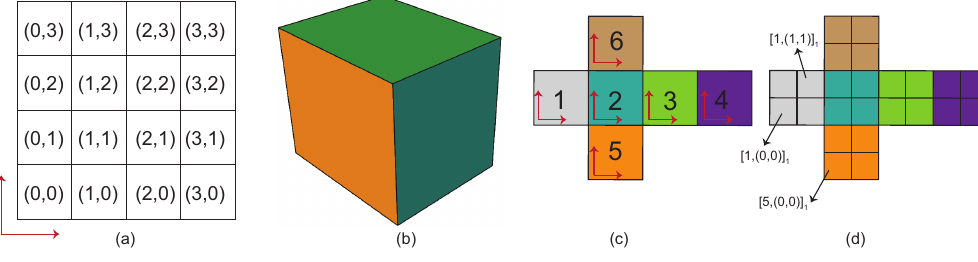
Figure 10. ( a ) Integer indexing of cells using Cartesian coordinates; ( b ) a cube; ( c ) the unfolded cube in (b) and coordinate systems for each face; ( d ) indices of some cells after one step of one-to-four